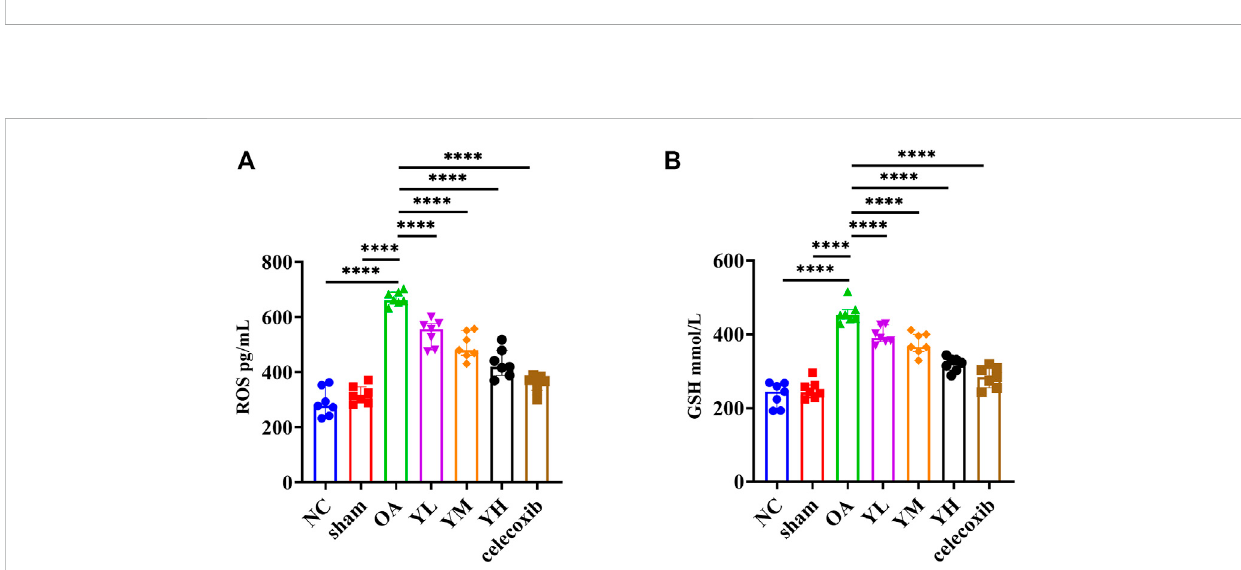
The effect of YQYXF on anti-oxidative stress and lipid peroxidation in OA rats. (A) Levels of ROS in plasma. (B) Levels of GSH in plasma. All data were expressed as mean ± SD. * p < 0.05, ** p < 0.01, *** p < 0.001, **** p <